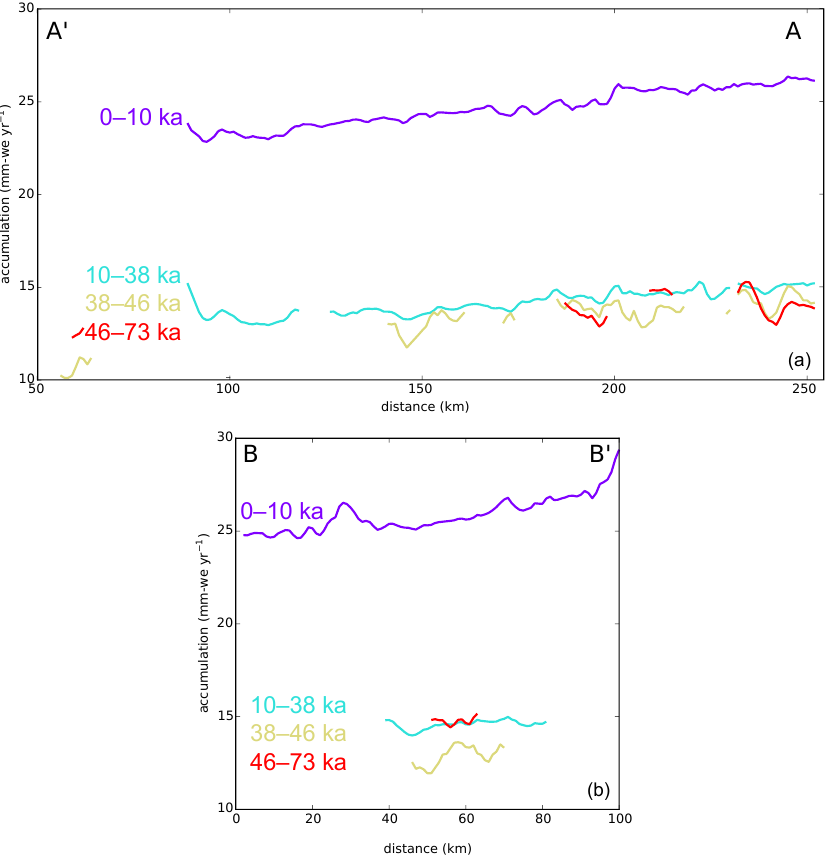
Figure 2. Paleoaccumulation rates per layer along radar lines. The age interval (cid:49)χ of each layer is indicated. Panel (a) shows the recon- structed paleoaccumulation rate a o ,(cid:49)χ along the A–A’ radar line. Panel (b) is along the B–B’ radar line. Both radar lines are highlighted on Fig. 1, distance represents kilometers along each radar line. Results are filtered to remove regions of excess horizontal strain. Both A–A’ and B–B’ display a consistent north–south accumulation gradient. The radargram for radar line B–B’ is shown in Supplement